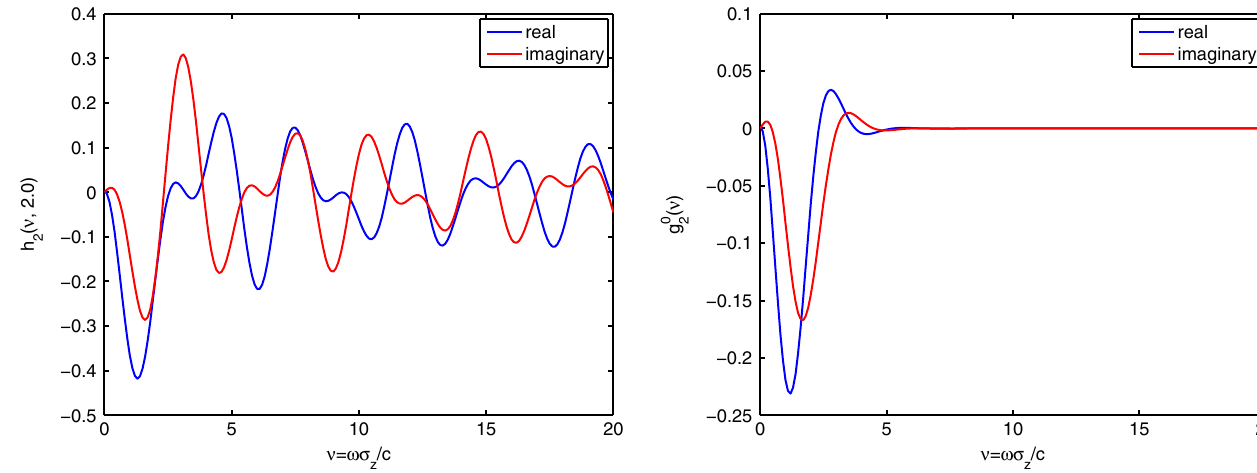
¼ 0 : 042 pC = V in the SLC damping ring. For the Gaussian model, their n